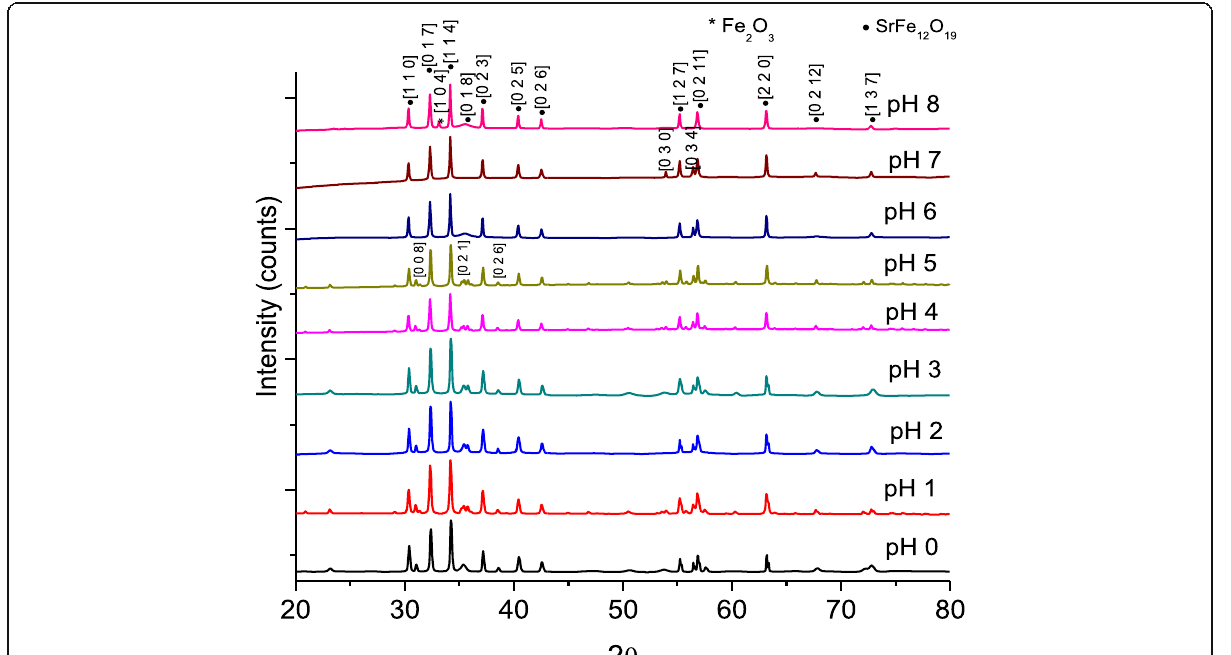
Fig. 2 The X-ray diffraction spectra of SrFe 12 O 19 for pH 0 to pH 8, sintered at 900